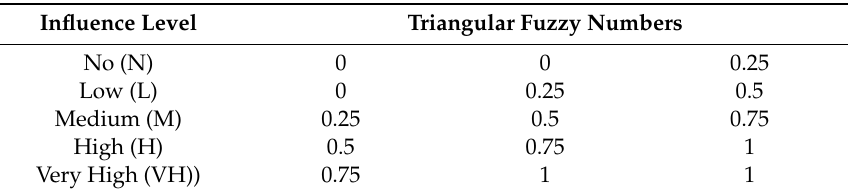
Table 2. Linguistic variables of the impact-relationship degrees.